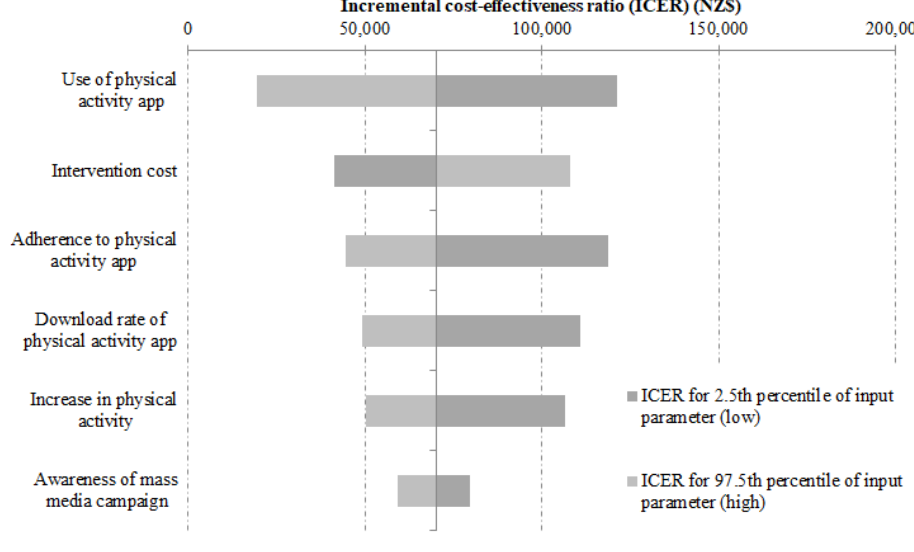
Figure 4. Tornado plot showing the contribution of parameter uncertainty to overall uncertainty in the incremental cost-effectiveness ratio for the whole adult